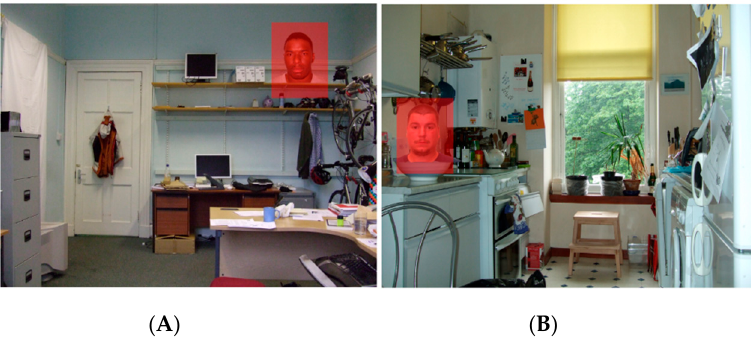
Figure 1. Examples of black ( A ) and white ( B ) face stimuli with AOI regions used for analyses overlaid.